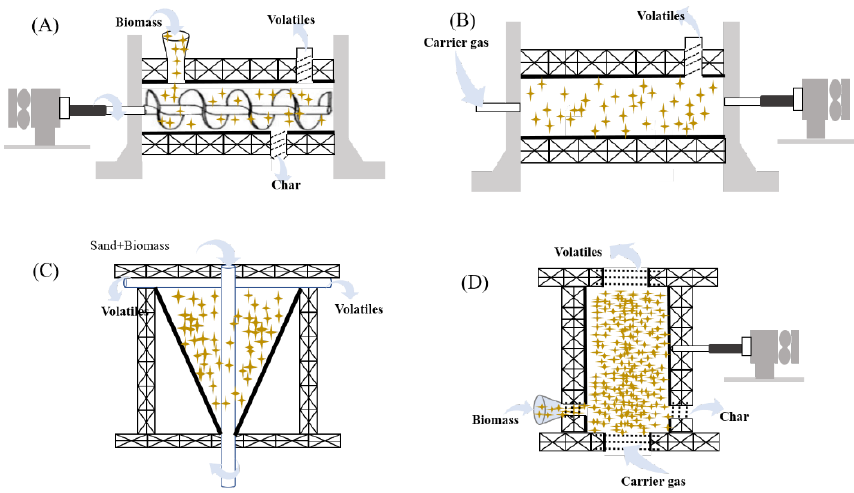
Figure 3. Diversity in pyrolysis reactors: ( A ) Auger reactor; ( B ) Fixed bed reactor; ( C ) Rotating cone reactor; ( D ) Fluidized bed reactor. Table 3. Advantages and disadvantages of different pyrolysis reactors.